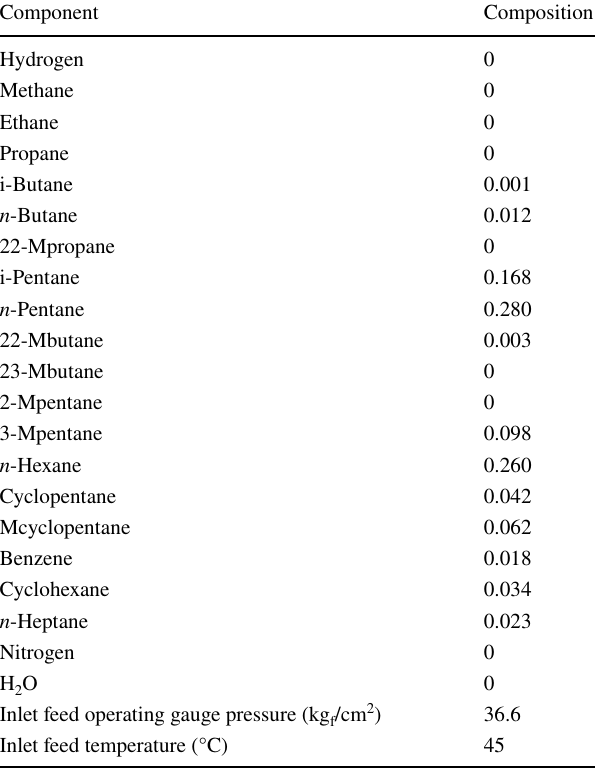
Table 10 Isomerization feed composition and isomerization inlet feed